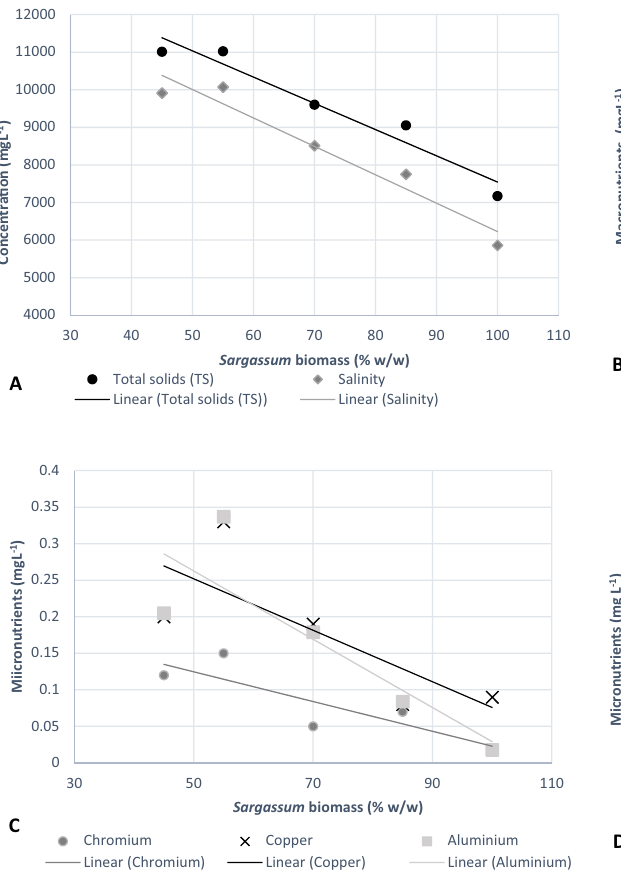
Fig. 3 Trends of the total solids, salinity, macronutrients (N, K, P), and minerals (Cr, Al, Cu, Bo, S) of the liquid residue derived from the anaerobic co-digestion of Sargassum spp . biomass and food waste Table 3 Biogas and methane yields during the anaerobic co- digestion of Sargassum spp. and